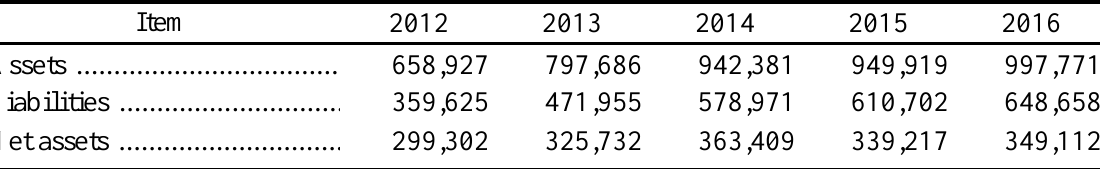
Trends in Japan's International Investment Position 1)